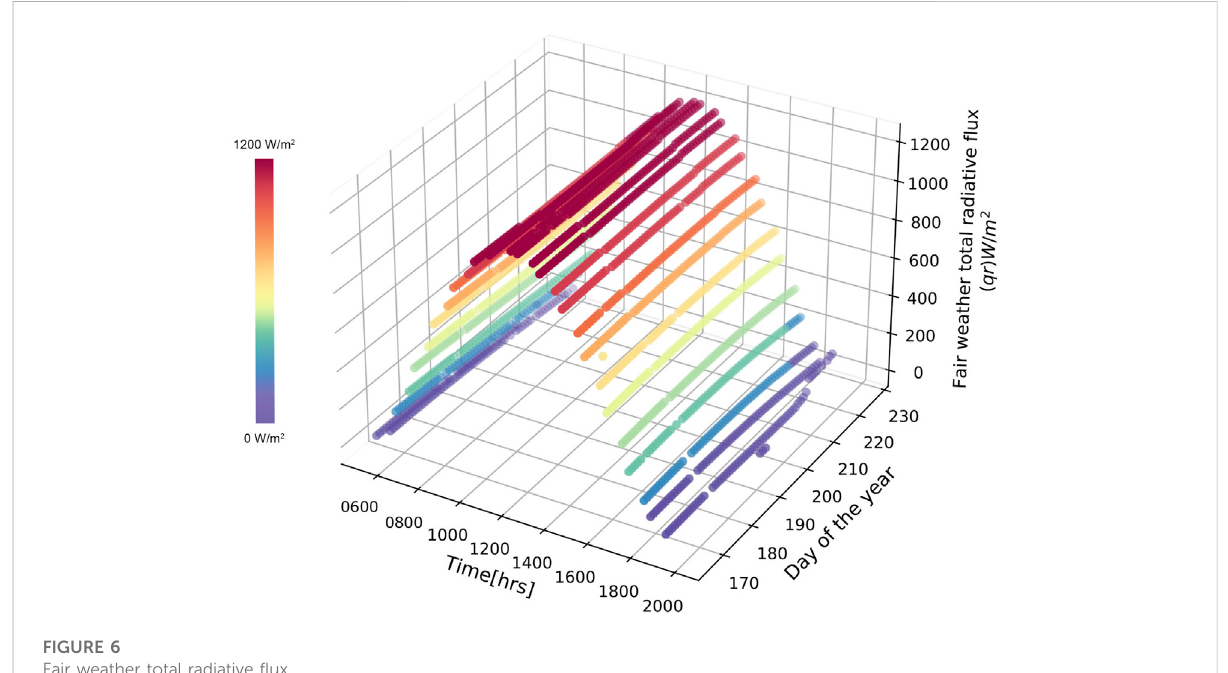
FIGURE 6 Fair weather total radiative fl ux.